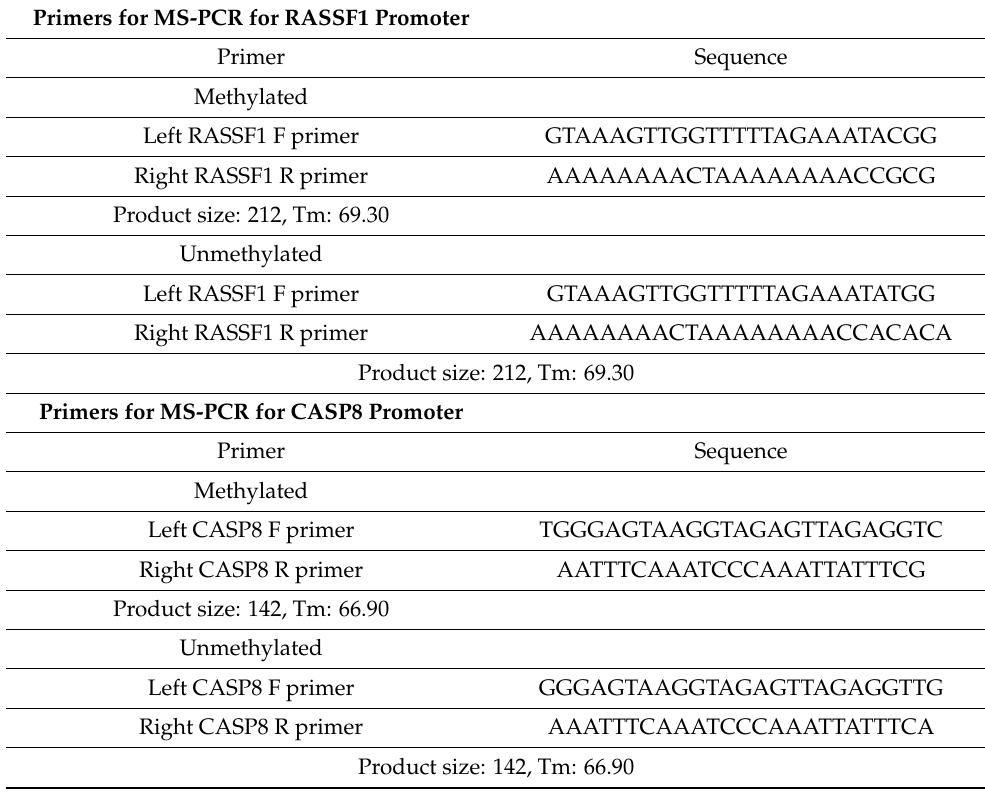
Table 2. Primer design for methylated and unmethylated RASSF1 and CASP8 genes. Primers for MS-PCR for RASSF1